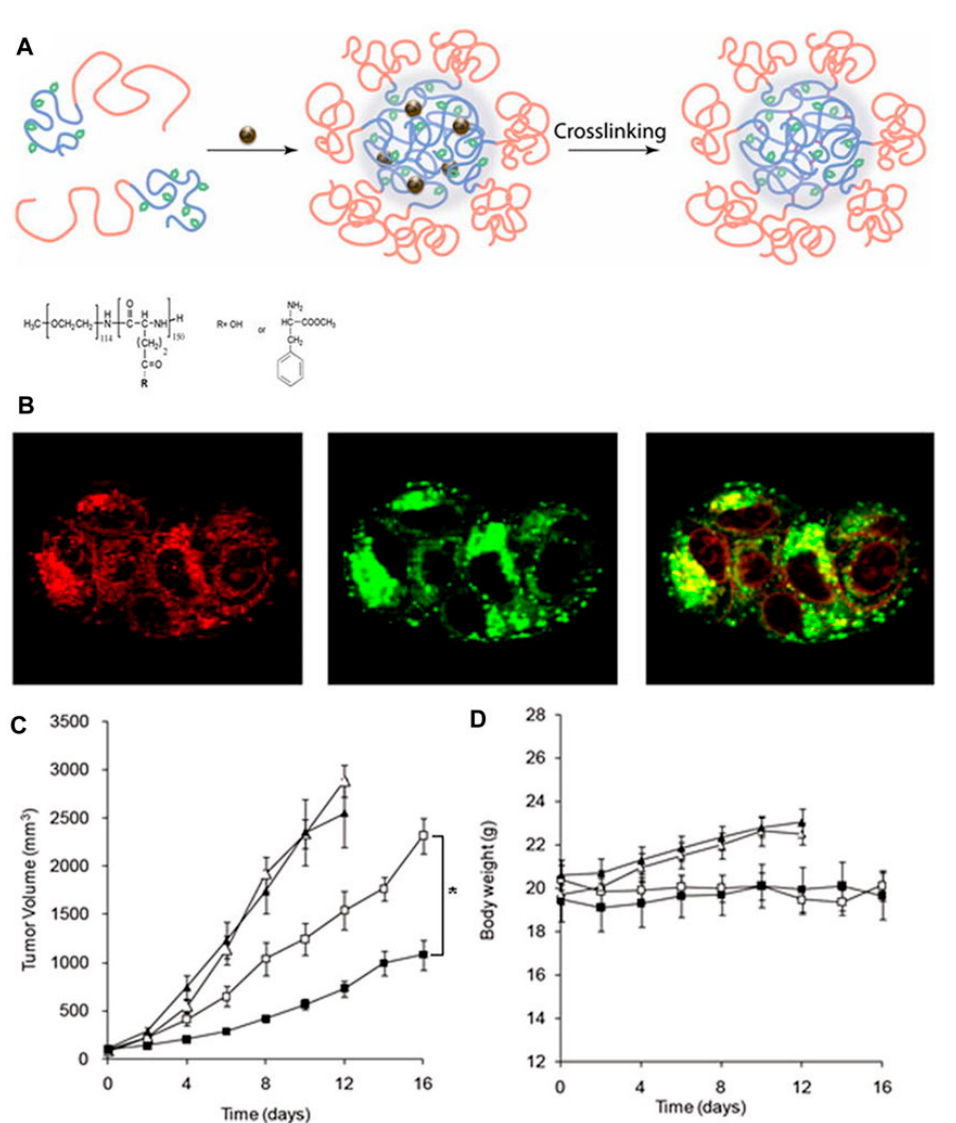
Figure 6. Synthesis and biological characterization of nanogels. ( A ) Schematic diagram of nanoparticle self-assembly. ( B ) Localization of DOX-loaded nanogels in cells. Effects of DOX-loaded nanogels on the tumor volume ( C ) and body weight ( D ) [178].